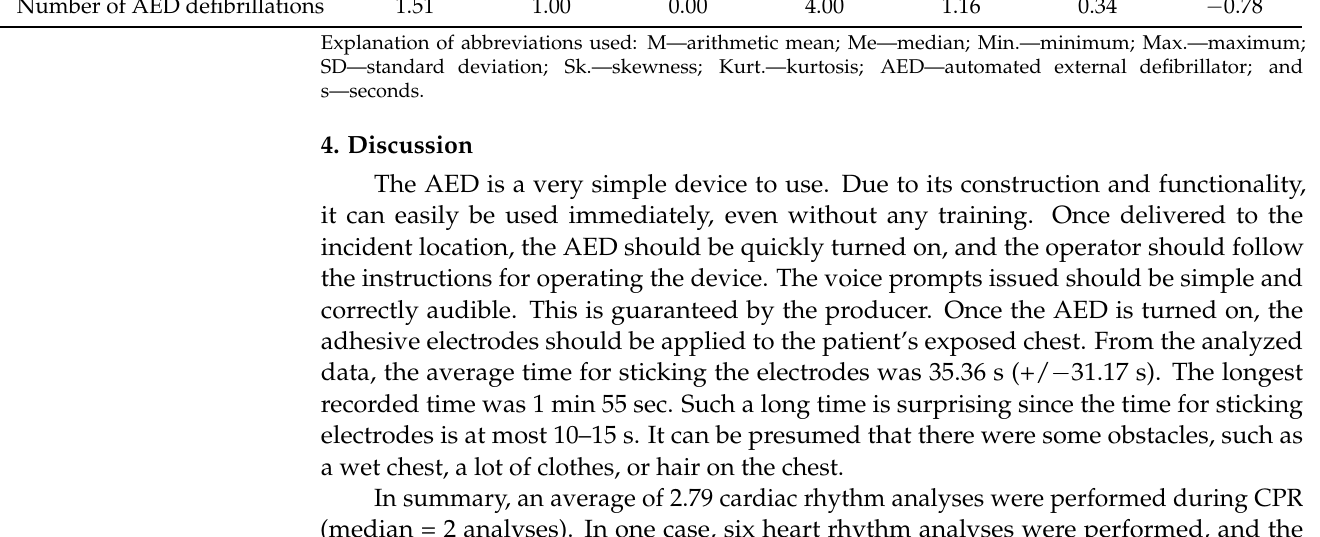
Table 3. Basic statistics on the number of defibrillations done with AED ( n = 33). M Me Min. Max. SD Sk. Kurt. Number of AED defibrillations 1.51